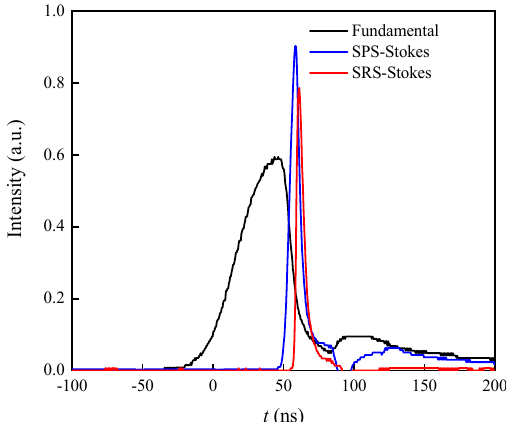
Figure 2. The pulse evolutions for the fundamental, SPS-Stokes, and SRS-Stokes waves. SPS: stimulated polariton scattering; SRS: stimulated Raman scattering.